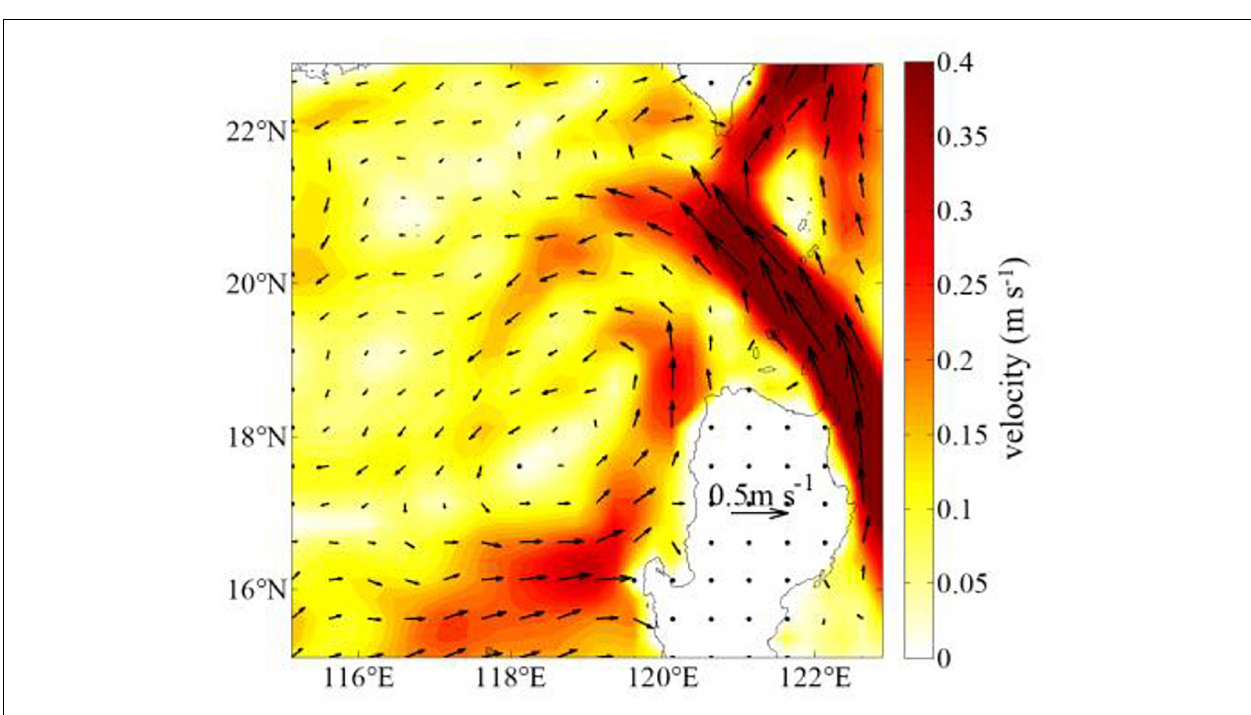
FIGURE 11 | The geostrophic flow velocity northwest of Luzon Island. The arrow indicates the direction and size of the geostrophic flow.